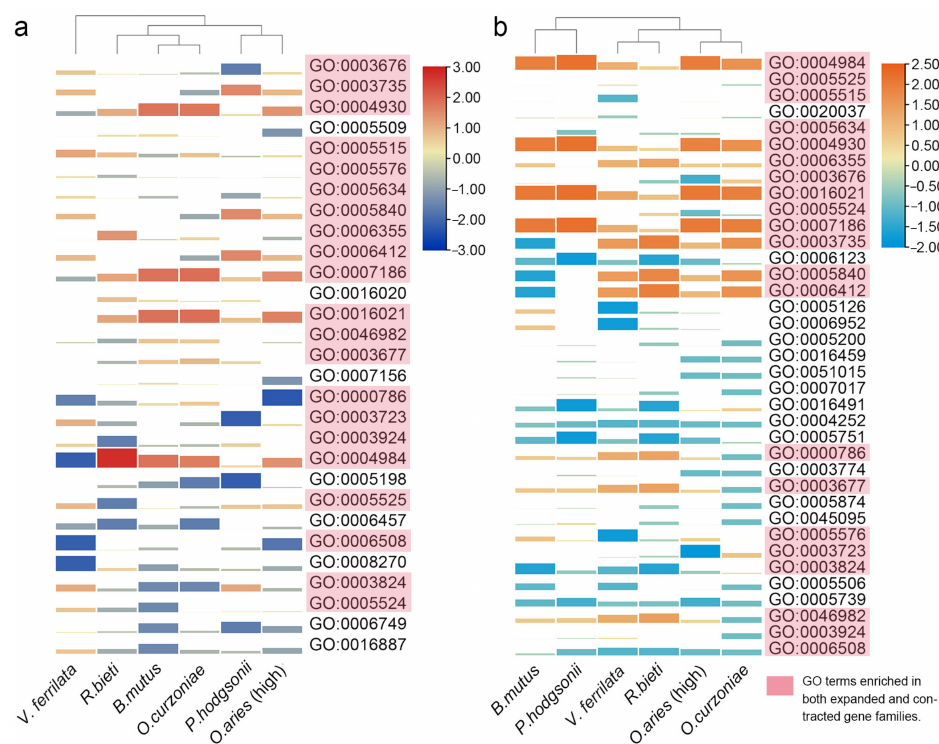
Figure 4. GO terms enriched in at least five high-altitude species were analyzed by clustering heat map. The color and area of each GO term for each species were log transformed from the number of gene families enriched in this GO term for each species. ( a ) Result of GO enrichment for significantly expanded gene families in at least five species. ( b ) Result of GO enrichment for significantly contracted gene families in at least five